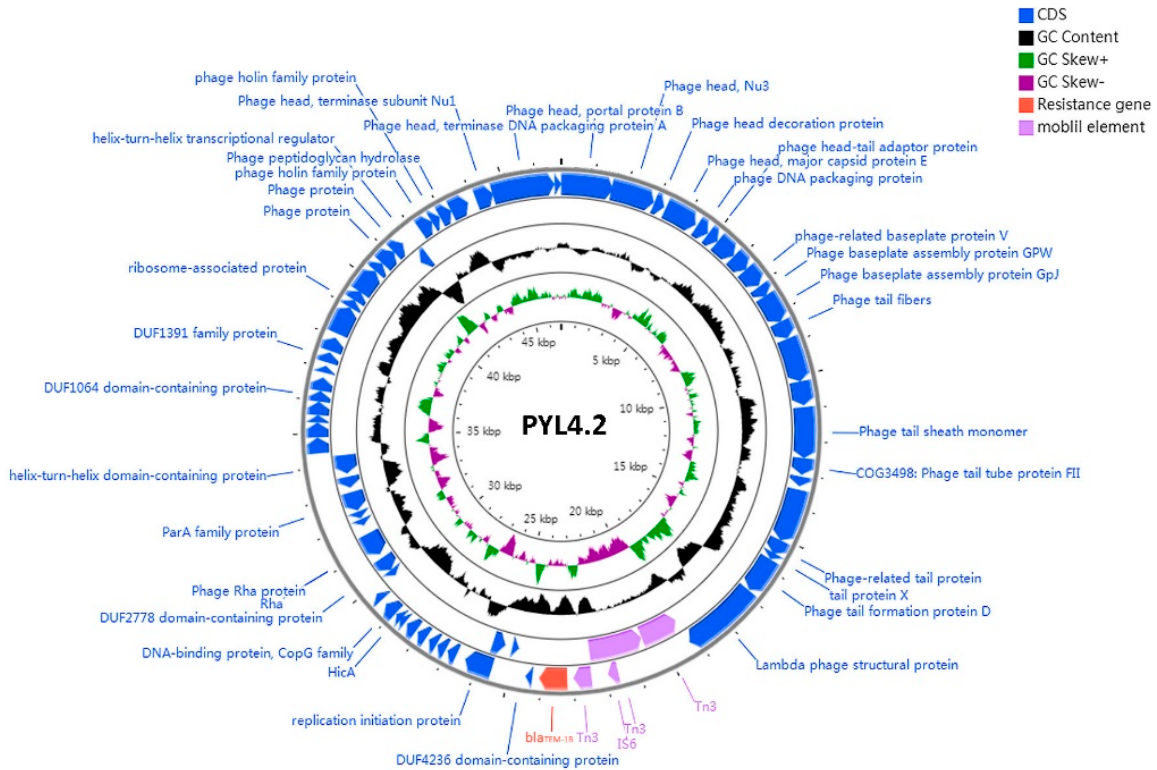
Figure 5. Structure of phage-like plasmid pYL4.2 carrying bla TEM-1B from S. marcescens isolate YL4. The arrows with different colors represent open reading frames (ORFs), with purple, orange, and blue representing mobile elements, resistance genes, and ORFs, respectively. Inner and outer circles correspond to average G+C content (black circle) and GC skew information (green and purple circles), respectively.